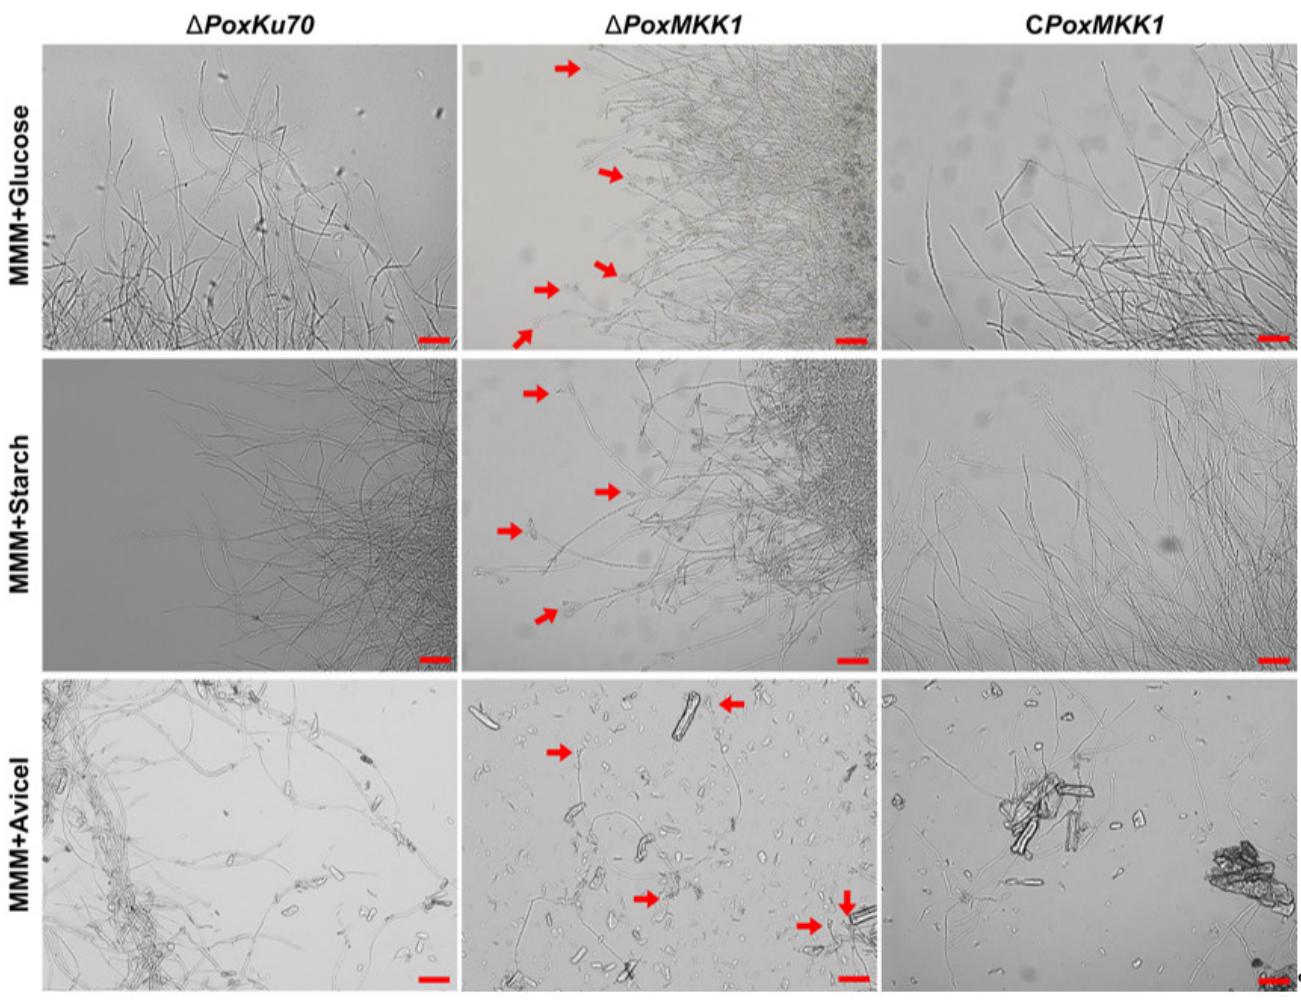
Figure 3. Microscopic images of hyphae in MMM containing 1.0% glucose, 1.0% SCS, and 2.0% Avicel as the solo carbon source at 28 °C for 24 h with 180 rpm (10 8 conidia/mL). The red arrowheads point to conidiophores. Scale bars = 50 μm.